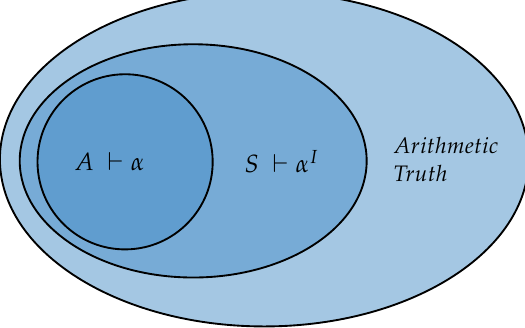
Figure 1. Expansion of validity under